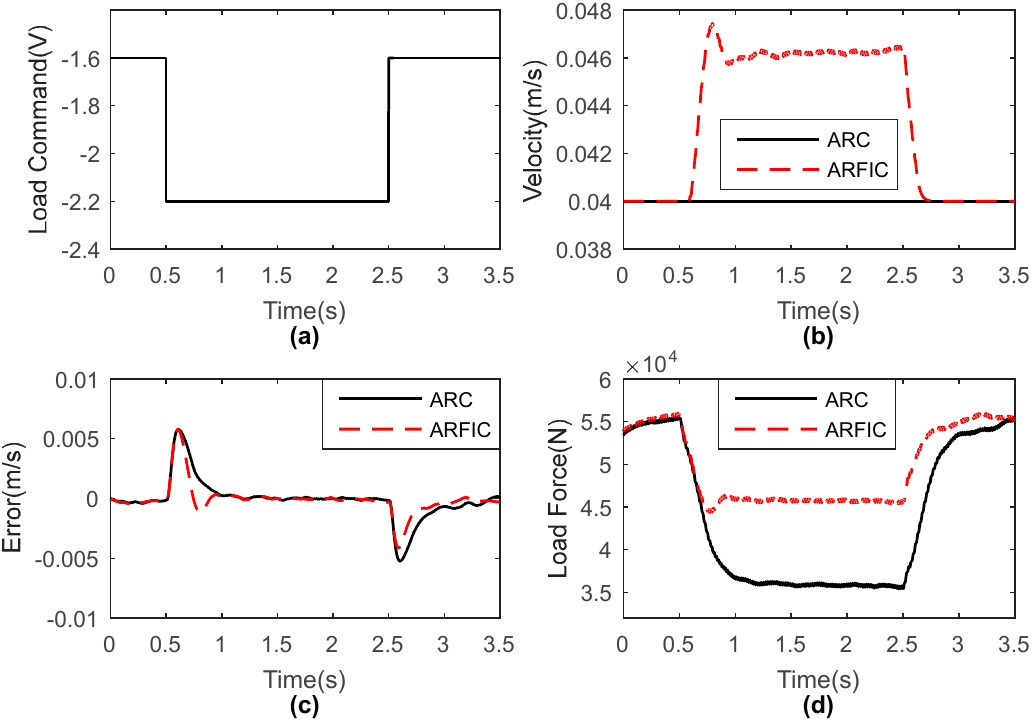
Figure 11. Tracking performance with a 0.04 m/s velocity command and − 1.6 V ∼ − 2.2 V ∼ − 1.6 V load command: ( a ) load command; ( b ) velocity commands; ( c ) velocity tracking errors; ( d ) load forces.